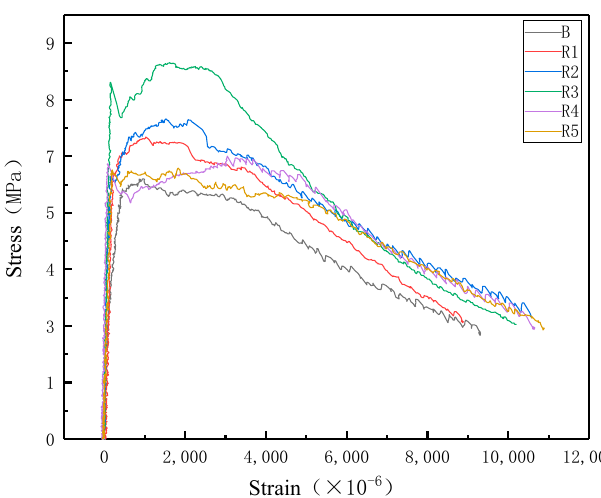
Figure 7. Tensile stress–strain curves of RBP UHPC under different substitution rates. Table 8. Tensile properties of recycled brick powder UHPC under different substitution rates. Group Elastic Ultimate Tensile Strength ( f te